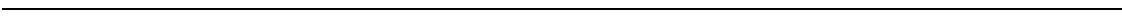
Fig. 1 Dim2 depletion blocks 90S biogenesis and causes a defect in Nob1 binding. a Yeast strain GAL::scDIM2 with integrated sc Enp1-FTpA or sc Rio2-FTpA was grown in galactose (GAL) medium or shifted for 8 h to glucose (GLU)-containing medium before the indicated bait proteins were tandem af fi nity- puri fi ed in two consecutive steps involving the ProtA- in the fi rst and the Flag-tag in the second step. TCA-precipitated fi nal Flag eluates were analyzed by SDS-PAGE (4 – 12%) and Coomassie staining (upper panel) or western blotting (lower panel) using the indicated antibodies. The indicated major protein bands were identi fi ed by mass spectrometry. Note that Dim1 co-migrates with HA-Dim2. b Recombinant MBP (maltose-binding protein)- ct Dim2 co- expressed with HIS 6 - ct Nob1 in E. coli BL21 cells was af fi nity-puri fi ed utilizing SP-Sepharose and subsequently Ni-NTA resin. The fi nal eluate was fractionated by size-exclusion chromatography (SEC). Relevant SEC fractions (lanes 15 – 21) containing the heterodimer were analyzed by SDS-PAGE (4 – 12%) and Coomassie staining. c Schematic drawing of the different ct Nob1 domains. The middle (MID) domain of Nob1 contains a highly conserved tryptophan at position W267, which was mutated and tested by binding to Dim2. d In vitro binding assay with immobilized GST- ct Dim2 as bait and indicated HIS 6 - ct Nob1 prey constructs (input, lanes 1 – 5). BL21 extract was used as mock control (input, lane 6). Samples (lanes 7 – 12) are SDS eluates analyzed by SDS-PAGE and Coomassie staining. e Single-point mutation in the ct Nob1-MID sequence causes loss of interaction with ct Dim2. Recombinant HIS 6 - ct Dim2 co-expressed with either ct Nob1 or ct Nob1 W267G in E. coli BL21 cells were tandem-puri fi ed on SP-Sepharose and Ni-NTA beads. Input Ni- NTA, lanes 1 and 3. Final eluates (lanes 2 and 4), analyzed by SDS-PAGE (4 – 12%) and Coomassie staining. The experiments were performed at least twice with consistent results. Uncropped images are shown in Supplementary Fig. 9. S molecular weight protein standard, L